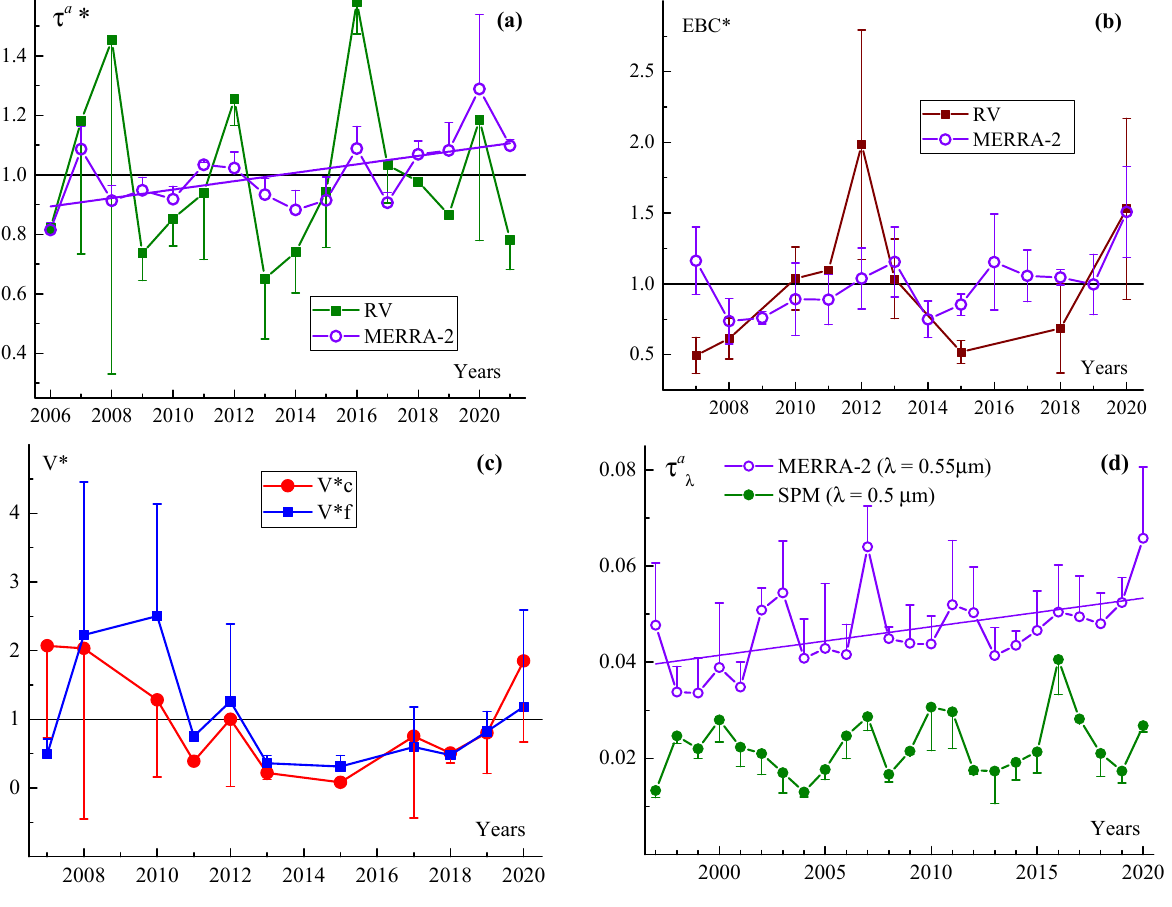
Figure 8. Interannual variations in aerosol characteristics over the Southern Ocean, using the data from MERRA-2 reanalysis and ship-based (RV) measurements: variations in ( a ) τ a *; ( b ) concentrations of EBC*; ( c ) particle volumes V f *, V c *; ( d ) and the absolute AOD values in the region of the Mirny observatory, using data from SPM photometer [61] and MERRA-2 reanalysis.